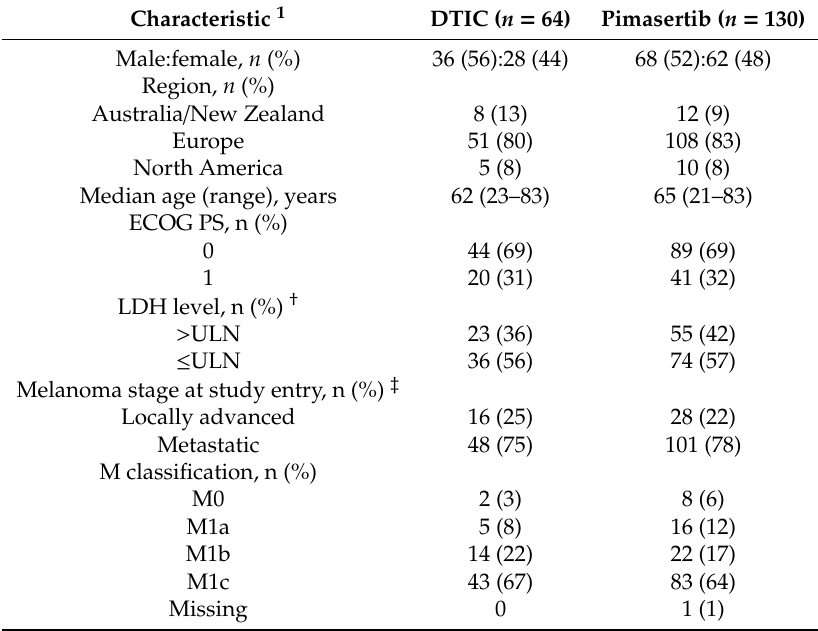
Table 1. Patient demographics and baseline characteristics (ITT analysis